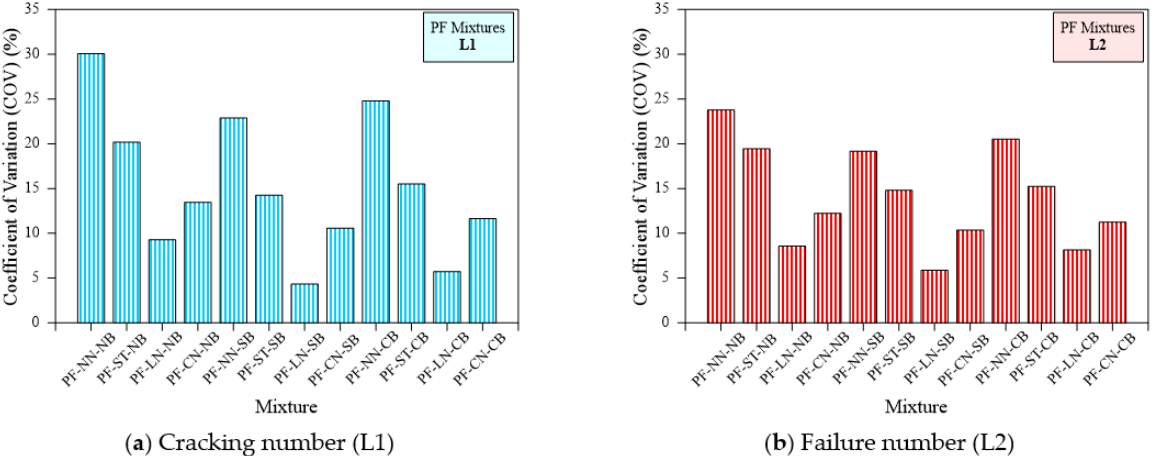
Figure 20. Coefficient of variation of cracking and failure impact numbers of PF specimens